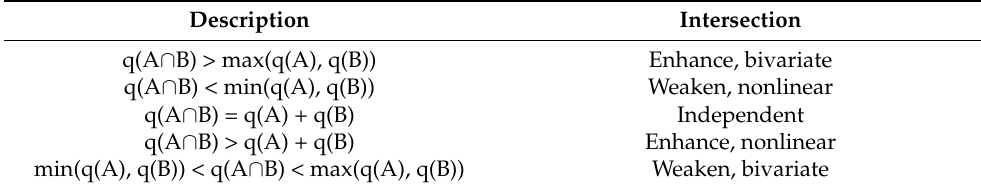
Table 3. Types of intersections in interactive detection.